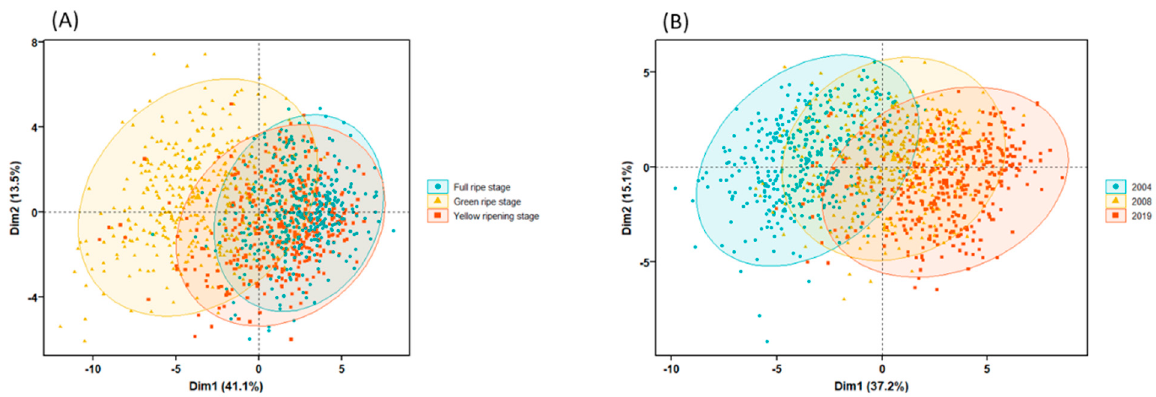
Figure 5. Principal component analysis based on multispectral data of alfalfa seeds of ( A ) different maturity levels and ( B ) harvest